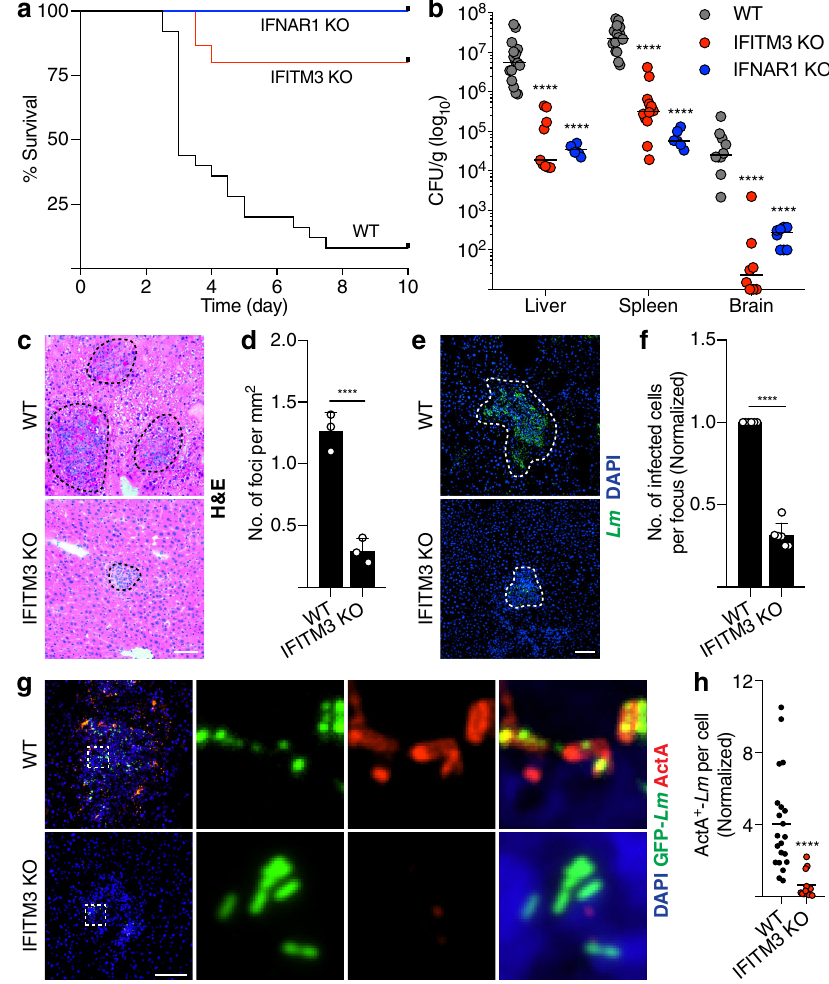
Fig. 6 IFITM3 promotes Lm infection in vivo. a 10-day survival rate of WT ( n = 25), IFITM3 ( n = 15), and IFNAR1 KO ( n = 10) mice infected with WT Lm plotted using Kaplan – Meier function. b Bacteria load of liver, spleen and brain of WT ( n ≥ 10), IFITM3 ( n ≥ 8), and IFNAR1 KO ( n ≥ 6) mice infected with Lm over 72 h. Representative images ( c , e ) and quanti fi cation ( d , f ) of infection foci taken from the liver of mice ( n = 3) 72 h p.i. Tissues were stained with H&E ( c , d ) or Lm and DAPI ( e , f ). Dotted lines delineate edge of the infection foci. Representative images ( g ) and quanti fi cation ( h ) of cell surface ActA expression by Lm in liver taken from mice ( n = 3) 72 h p.i. Data shown are medians ( b , h ) or means± s.d. ( d , f ). P value was calculated using